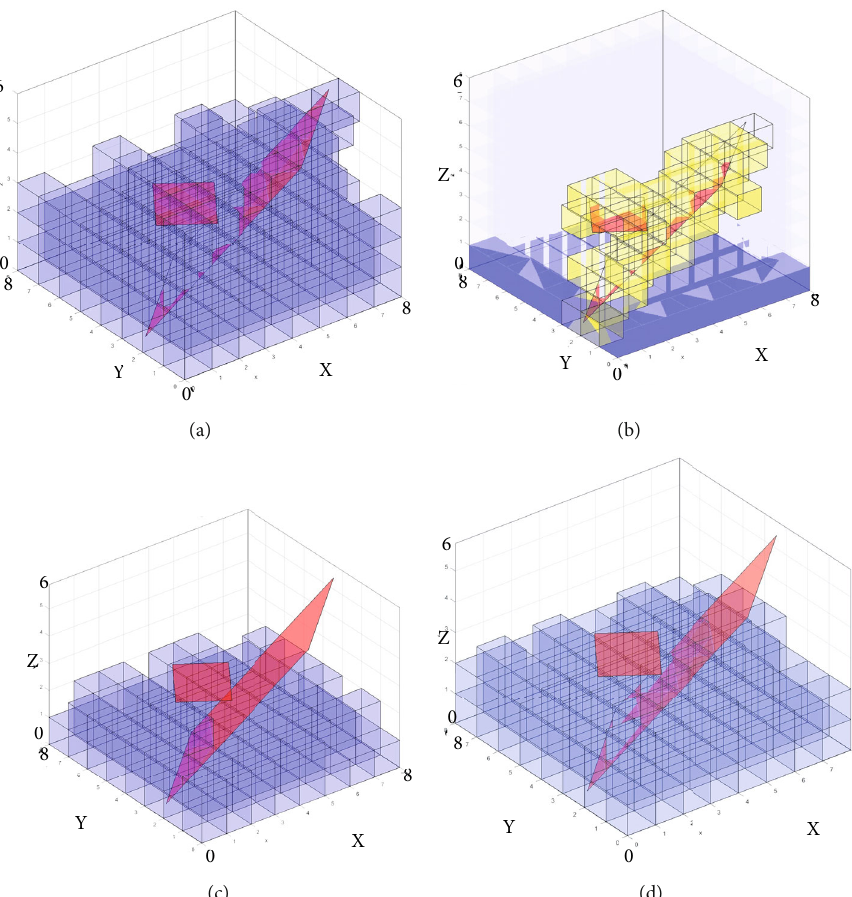
Figure 7: Simulation of the imbibition process in a square-shaped rock with fractures, with fracture-containing grid cells shown in yellow, at (a) fi rst, (b) second, (c) fourth, and (d) six di ff erent steps of